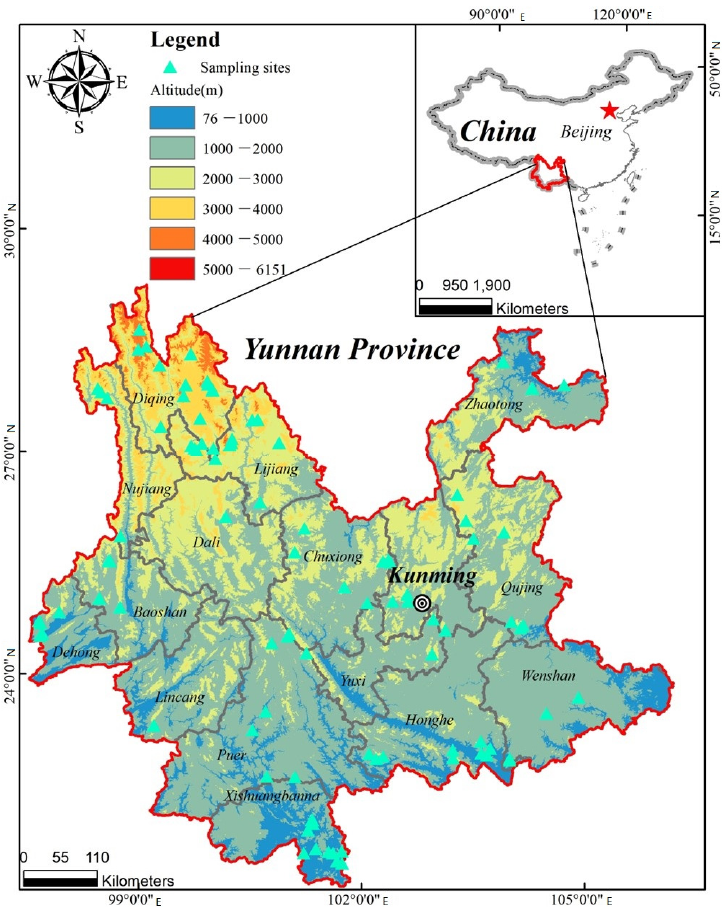
Figure 1. Distribution map of soil sampling sites in Yunnan Province, China.